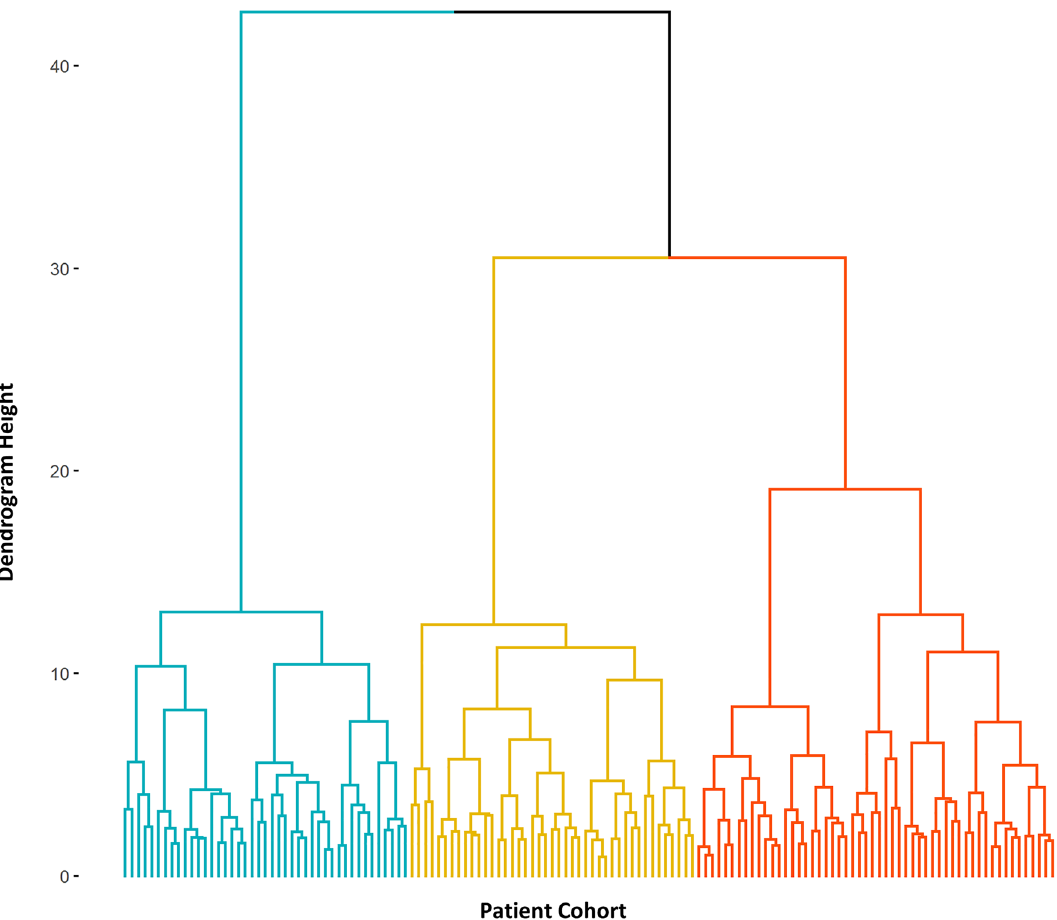
Figure 2. Dendrogram of hierarchical cluster analysis. Hierarchical cluster analysis identified three distinct groups of AMI patients based on ECM biomarker levels. This image was created using the factoextra package in R version 4.0.2, www.R- proje ct.